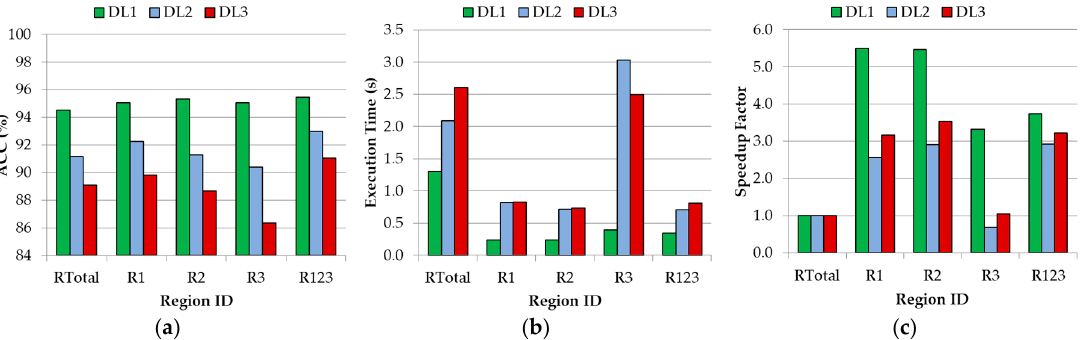
Figure 9. Average of the overall accuracy results ( a ), execution time ( b ), and speedup factor (respect to the R Total execution time) achieved with the SVM RBF kernel with the optimal hyperparameters for each DL, using the different wavenumber regions.